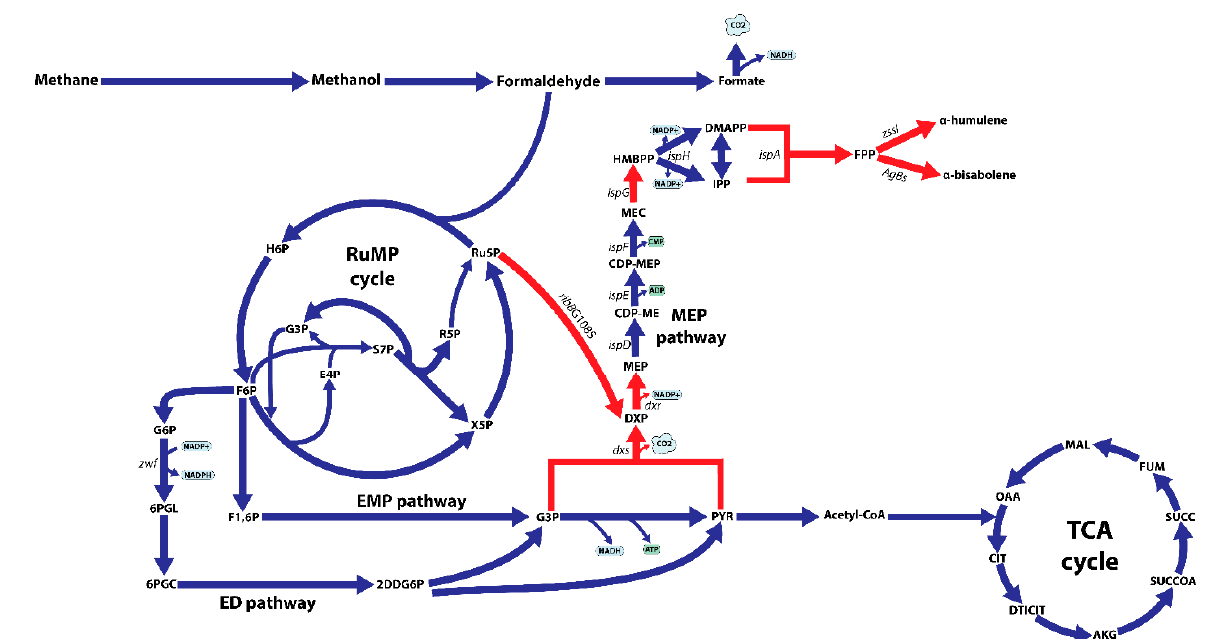
Figure 1. Schematic overview of the central metabolism of M. alcaliphilum 20Z on methane, including the ribulose monophosphate (RuMP) cycle, the Embden–Meyerhof–Parnas (EMP) pathway, the Entner–Doudoroff (ED) pathway, the TCA cycle, endogenous isoprenoid synthesis via the methylerythritol 4 ‐ phosphate pathway (MEP). Abbreviations: H6P, hexulose 6 ‐ phosphate; F6P, fructose 6 ‐ phosphate; X5P, xylulose 5 ‐ phosphate; Ru5P, ribulose 5 ‐ phosphate; E4P, erythrose 4 ‐